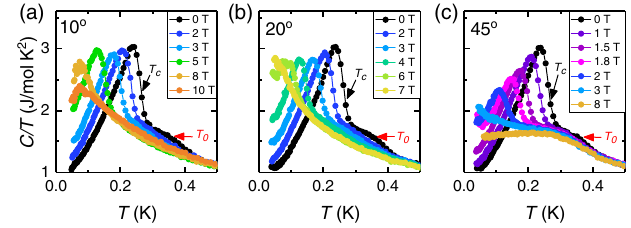
FIG. 3. (a) – (c) Temperature dependence of the specific heat C=T in magnetic field at different angles. Here, a nuclear contribution has been removed